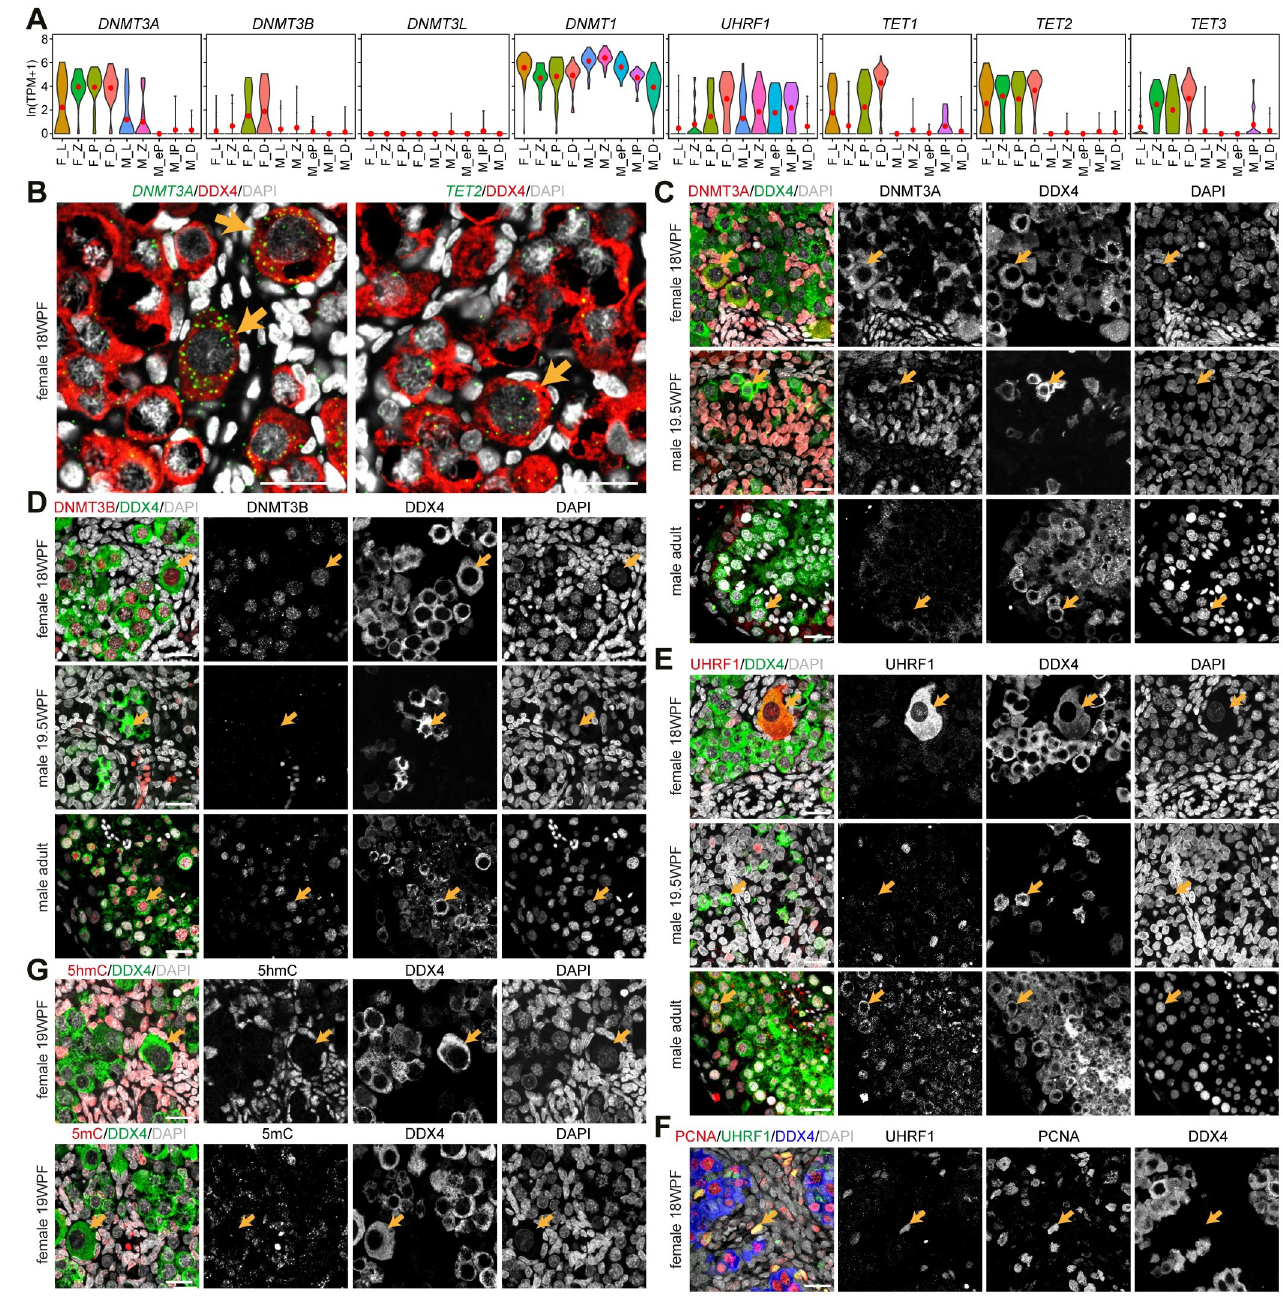
Fig 4. Regulation of DNA methylation during meiotic prophase I in males and females. (A) Violin plots showing expression of selected enzymes involved in the regulation of DNA methylation. Red dots mark mean expression per cluster. (B) RNA FISH of DNMT3A (left) or TET2 (right) together with DDX4 in 18WPF ovaries. Orange arrows indicate dictyate/diplotene oocytes. (C-E) Immunofluorescence for DNMT3A (C) , DNMT3B (D) and UHRF1 (E) with DDX4 in 18WPF ovaries, 19.5WPF testes and adult testes. Orange arrows in 18WPF ovaries indicate dictyate/diplotene oocytes and in testes indicate representative DDX4+ germ cells. Scale bars are 20 μ m. (F) Immunofluorescence for UHRF1 and PCNA in 18WPF ovaries. Orange arrows indicate representative UHRF1 +PCNA+ proliferating gonadal somatic cells. Scale bars are 20 μ m. (G) Immunofluorescence for 5-hydroxymethylcytosine (5hmC) and 5-methylcytosine (5mC) in 19WPF ovaries. Orange arrows indicate dictyate/diplotene oocytes. Scale bars are 20 μ m.